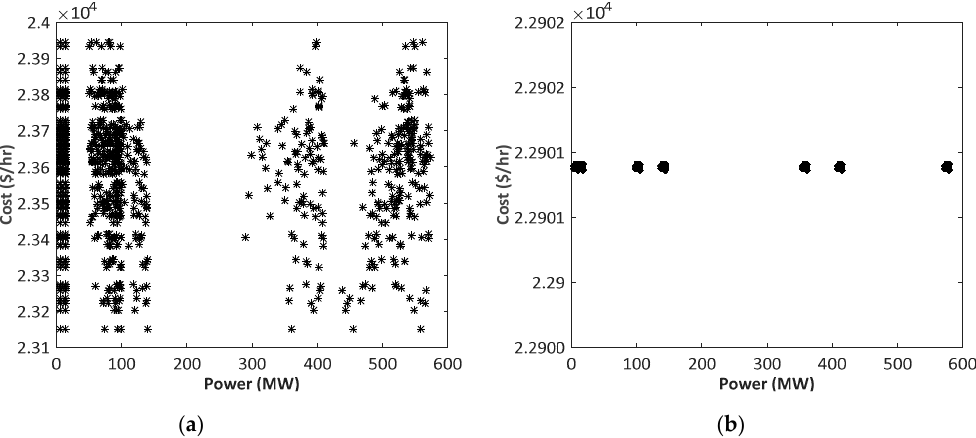
Figure 6. Bats positions in the dBA ( a ) before and ( b ) after 1000 iterations (seven-unit system with renewables).